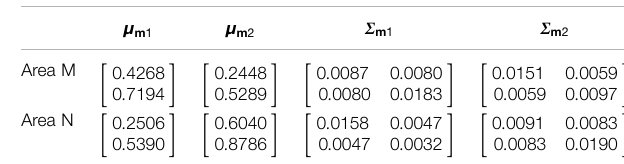
TABLE 1 | Gaussian mixture model parameter